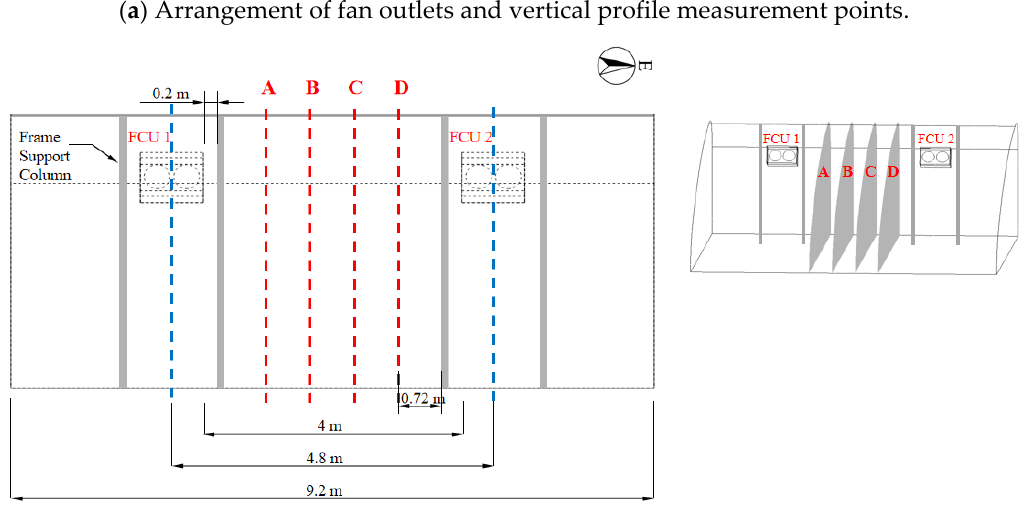
Figure 2. Schematic diagrams of the two identical FCU systems and arrangement of the measuring points.